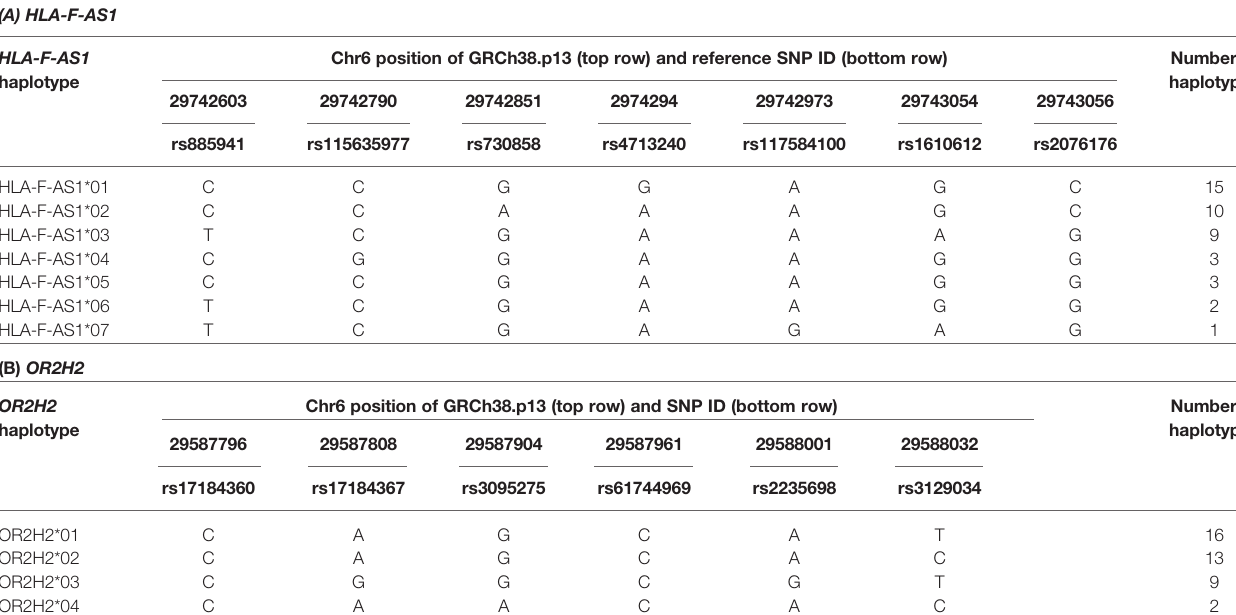
TABLE 2 | Characteristics of HLA-F-AS1 and OR2H2 DNA polymorphic